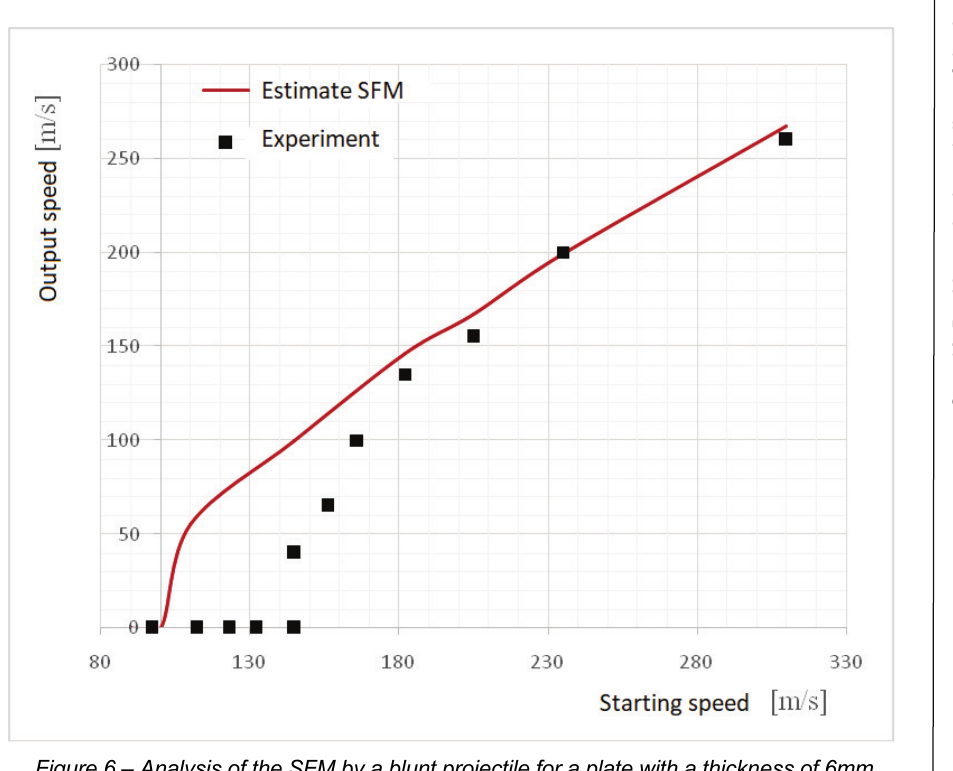
Figure 6 – Analysis of the SFM by a blunt projectile for a plate with a thickness of